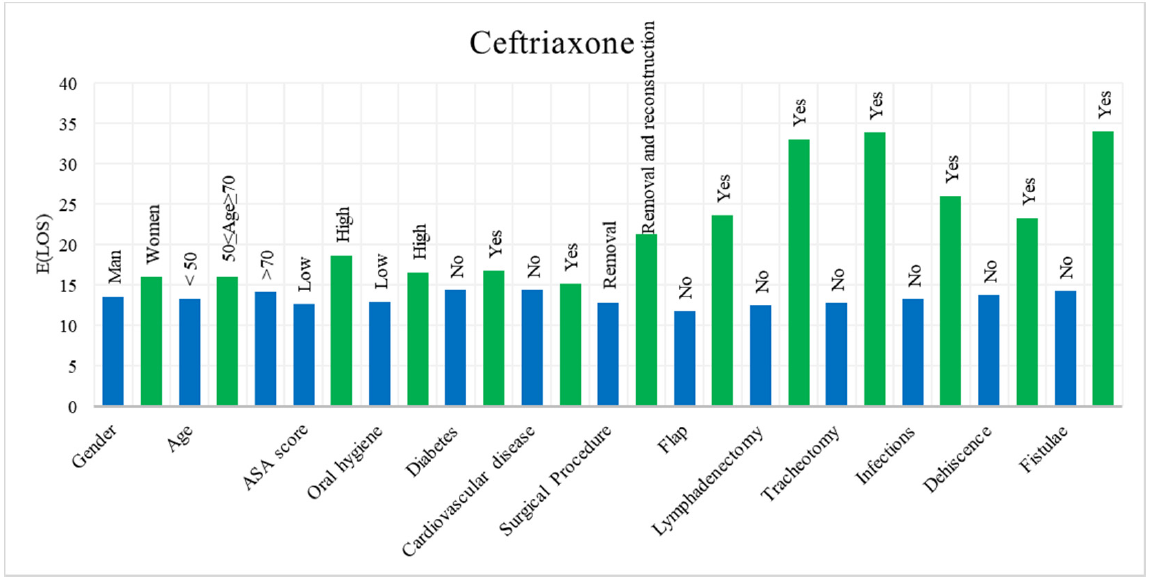
Figure 2. Mean LOS for each category of variables regarding Ceftriaxone.